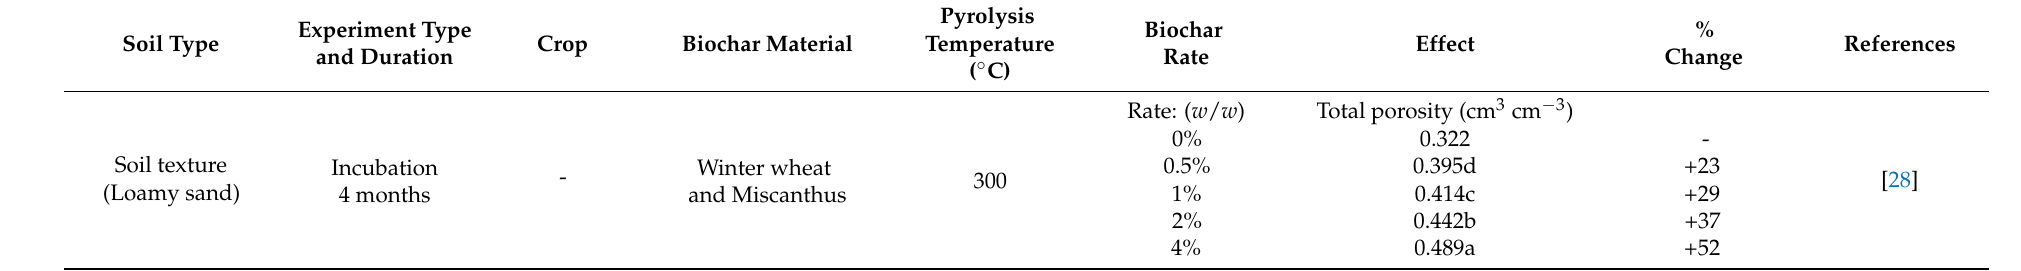
Table 6. Changes in soil porosity by biochar incorporation (different letters in the same column indicating significant difference among the biochar